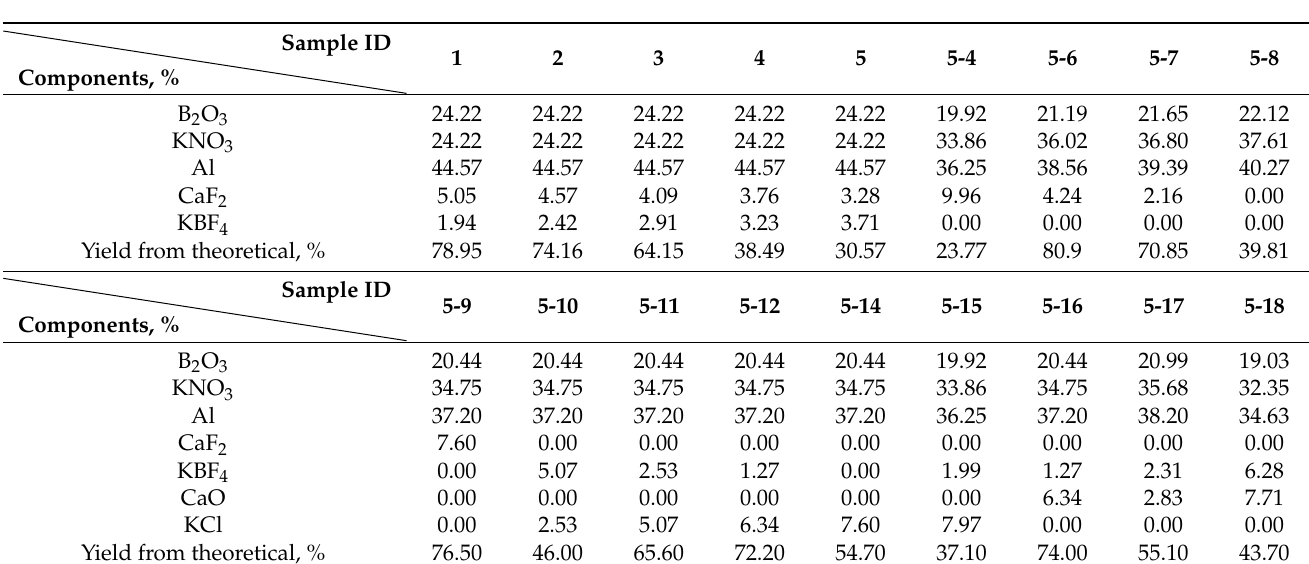
Table 5. Summary of experimental data for choosing the optimal composition of the fluxing additive and its effect on the yield of the